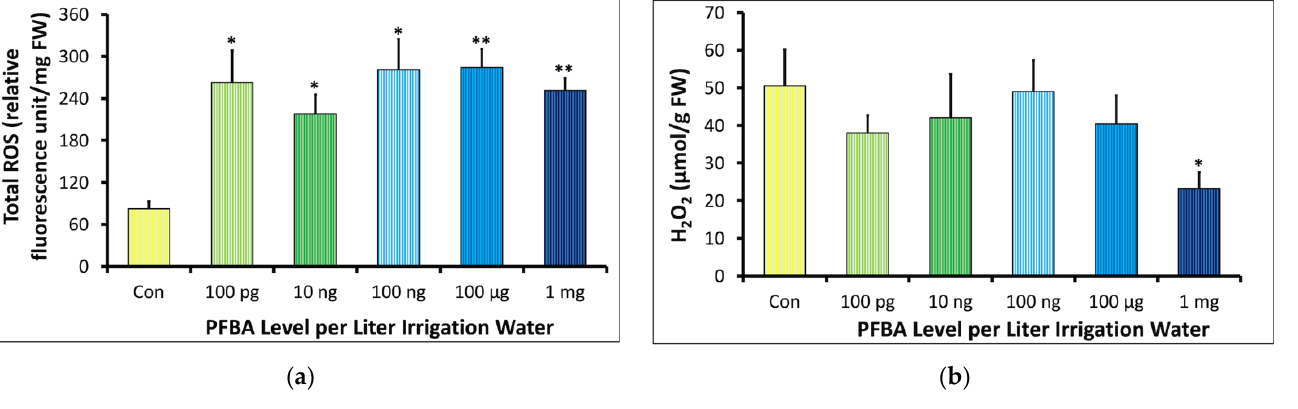
Figure 4. Dose – response relationship between the concentration of PFBA in irrigation water and reactive oxygen species in leaves of soybean plant grown for 5 weeks. The * and ** symbols indicate significant difference between the treatment and control at p < 0.05 and p < 0.01, respectively ( n = 3). ( a ) shows the total reactive oxygen (ROS) concentration across all groups, with higher levels observed in the PFBA treatments compared to the controls, ( b ) shows the hydrogen peroxide (H 2 O 2 ) levels did not increase as observed for systems with increased ROS.